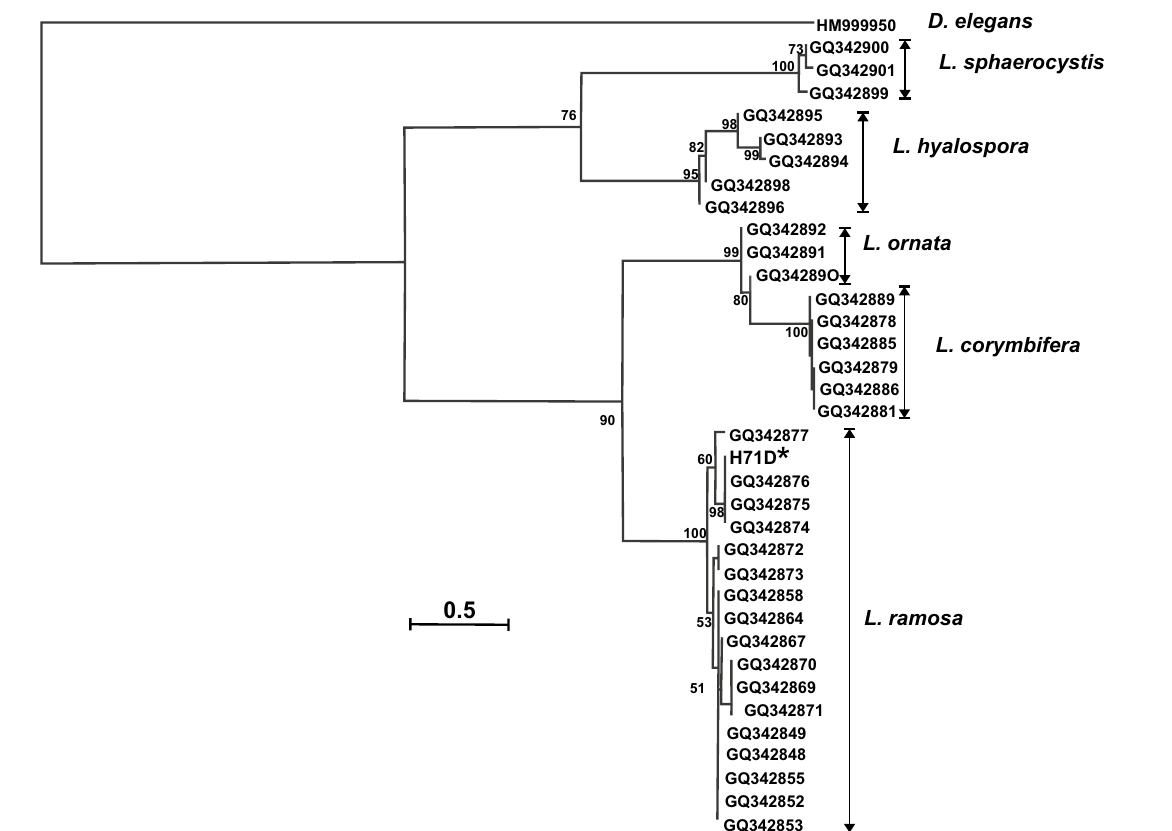
Fig. 1 Phylogenetic tree inferred from ITS DNA sequences from Lichtheimia species. The tree was inferred under PhyML algorithm using an HKY85 model. The numbers on the branches correspond to the robustness (bootstrap values) obtained from 100